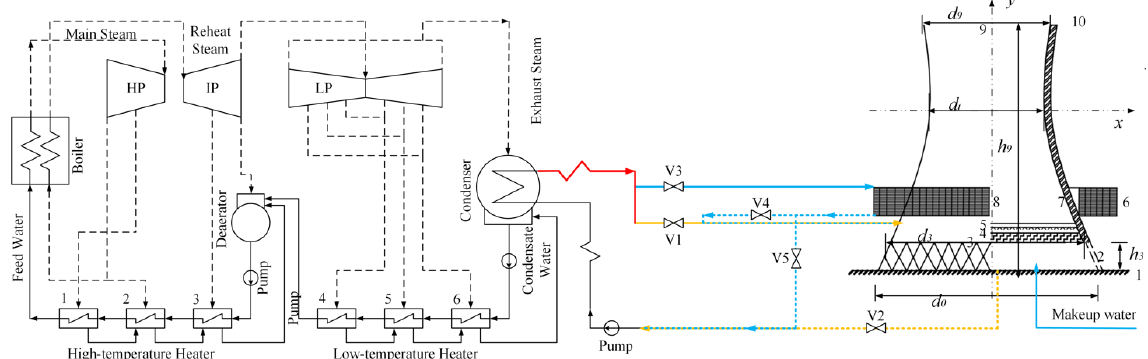
Figure 1. Schematic diagram of a power generating unit coupled with the hybrid cooling system.